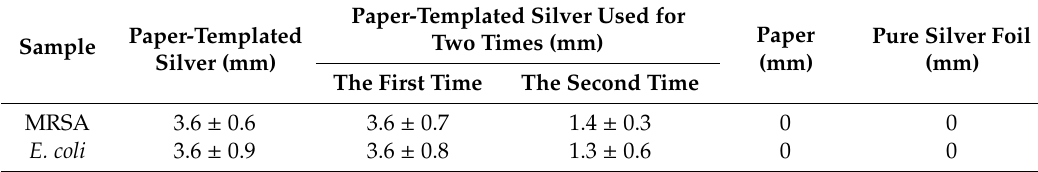
Figure 5. Antibacterial property of the paper-templated silver. Digital photographs of four samples against ( A ) MRSA and ( B ) E. coli in agar dishes. The four samples are (1) the paper-templated silver, (2) the paper-templated silver used for the second time, (3) paper, and (4) pure silver foil. Table 1. The size of the inhibition zones of four samples against the Gram-positive bacteria MRSA and Gram-negative bacteria E. coli (n =